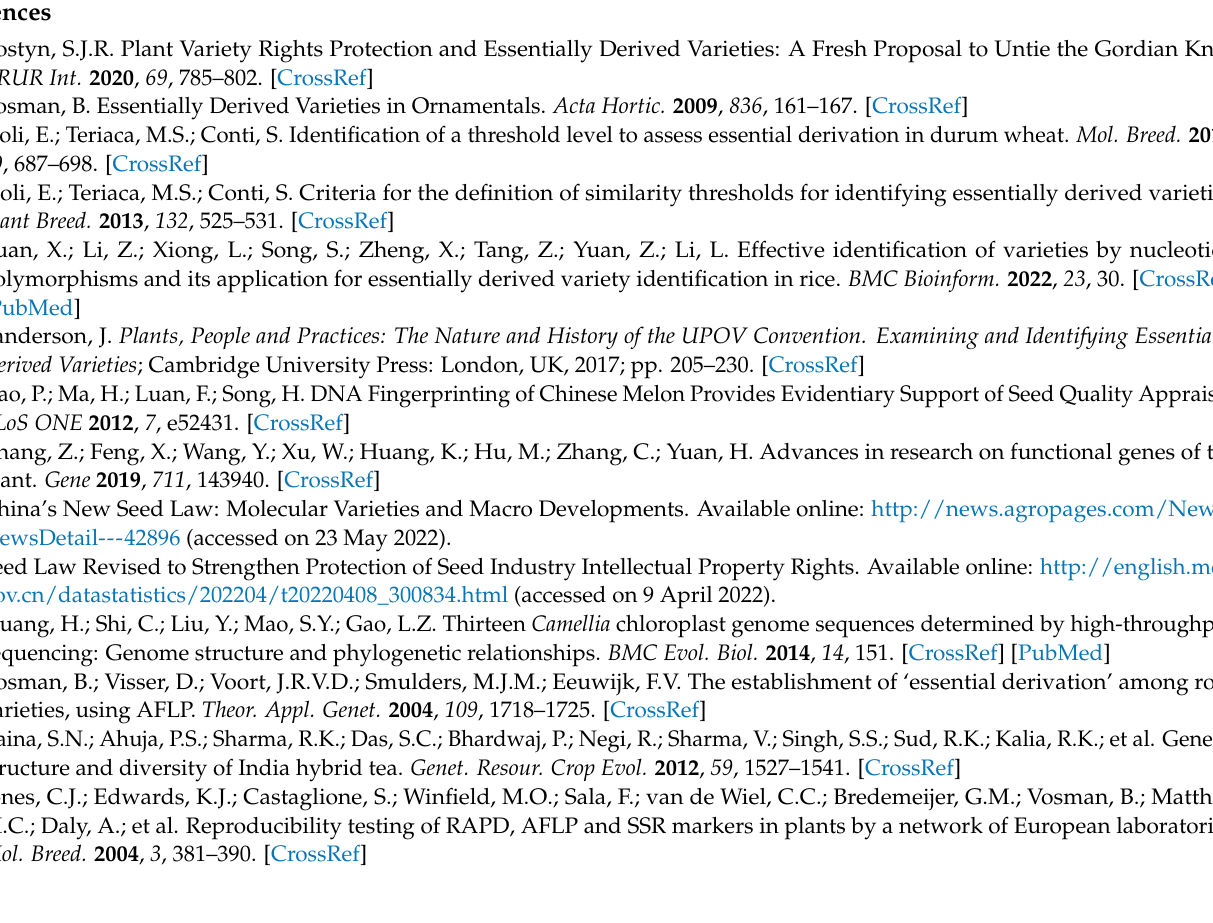
trees; Table S6: Accession pairs with essentially derived relationships (GS > 0.9) within 349 tea trees; Table S7: Analysis of essentially derived variety/strain within 349 tea trees; Table S8: A genetic similarity matrix was built based on the number of differential SNP genotypes between each sample among 349 tea trees; Table S9: Analysis of the core variety in 5 populations within 349 tea trees; Table S10: The 21 SNP markers polymorphism for 349 sample identification; Table S11: The 21 pairs of primers for 349 tea trees rapid